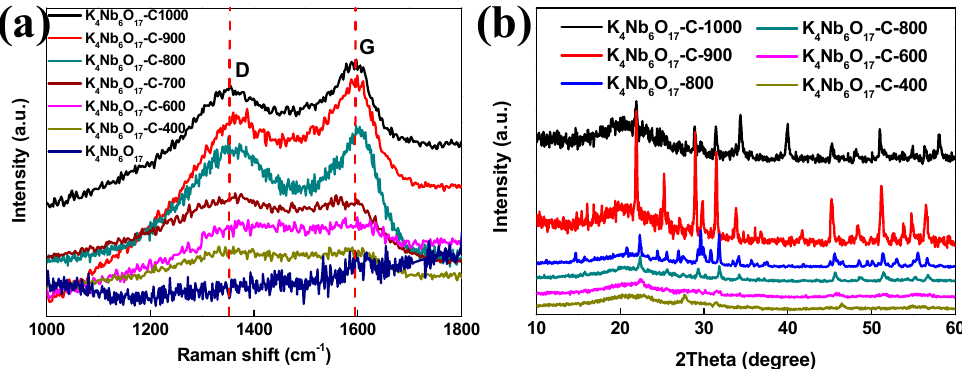
Figure 4. ( a ) Raman spectra of K 4 Nb 6 O 17 -C-800. ( b ) XRD patterns of K 4 Nb 6 O 17 -C.